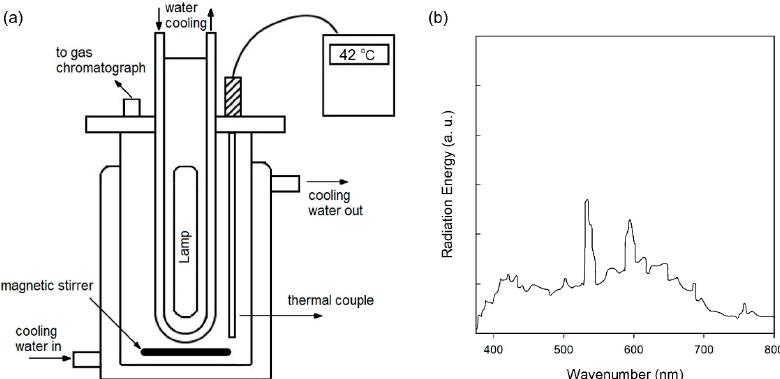
Figure 1. ( a ) Closed reaction system for photocatalysis water splitting ( b ) Emission spectrum of 150 W Xe lamp.